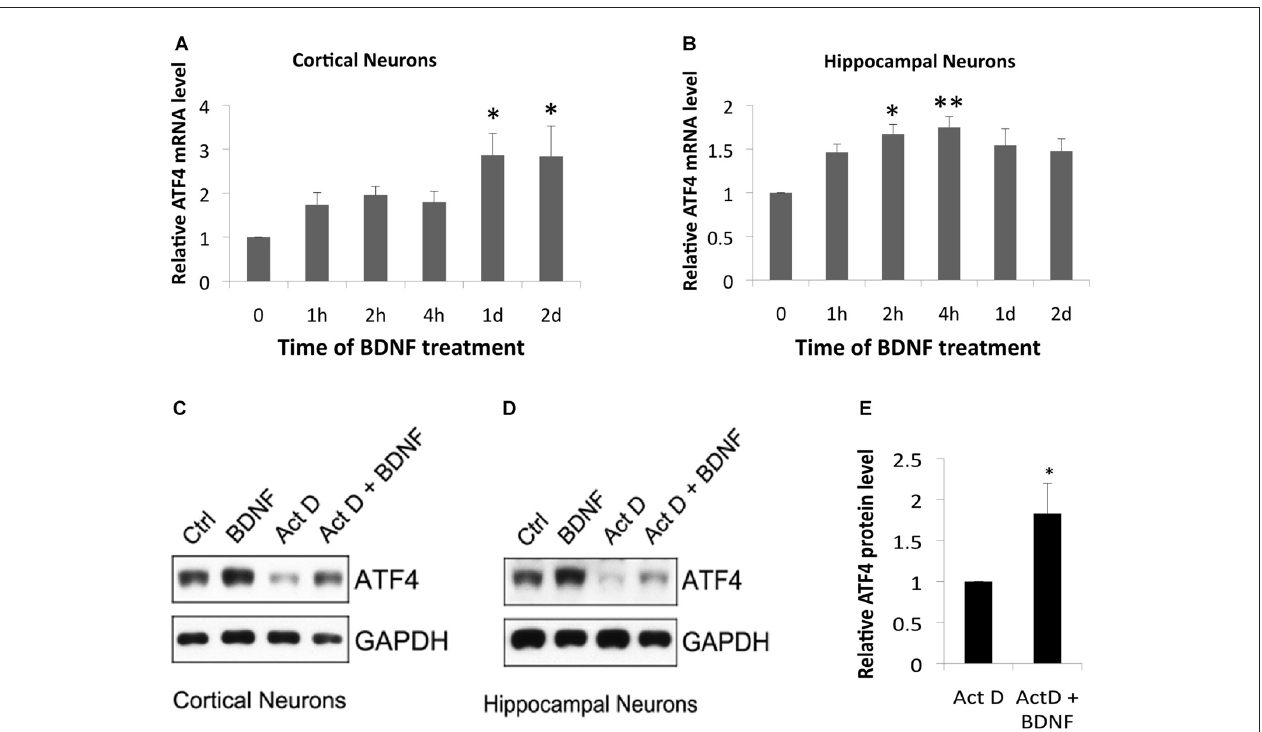
FIGURE 4 | BDNF elevates ATF4 in neurons via both transcriptional and non-transcriptional mechanisms. (A,B) BDNF elevates Atf4 mRNA in cultures of cortical (A) and hippocampal (B) neurons. Cultures (12 DIV) were exposed to 25 ng/ml BDNF for the indicated times and assessed by qPCR for Atf4 mRNA levels (normalized to alpha-tubulin). Values represent means ± SEM for three (cortical cultures) or five (hippocampal cultures) independent experiments, with one lysate per time point and qPCR performed in triplicate. p values were calculated vs. no BDNF treatment using the Kruskal-Wallis test [overall p = 0.04 (A) and 0.037 (B) ] with the post hoc Conover method adjusted by the FDR procedure of Benjamini-Hochberg. ∗ p = 0.009 (A) and 0.031 (B) . ∗∗ p = 0.014 (B) . (C,D) BDNF elevates ATF4 protein in cultured cortical and hippocampal neurons in part via a transcription-independent mechanism. Cultures were pre-treated ± the RNA synthesis inhibitor actinomycin-D (0.2 µ M) for 0.5 h and then with or without 25 ng/ml BDNF ± actinomycin-D for 2 h and then total cell extracts were subjected to Western immunoblotting as indicated. (E) Quantification of relative ATF4 protein levels in hippocampal cultures treated with actinomycin-D alone or with actinomycin-D + BDNF indicates transcription-independent regulation of ATF4 expression. Values represent means ± SEM for four independent experiments, each with a single cell lysate per condition. ∗ p = 0.004 ( t